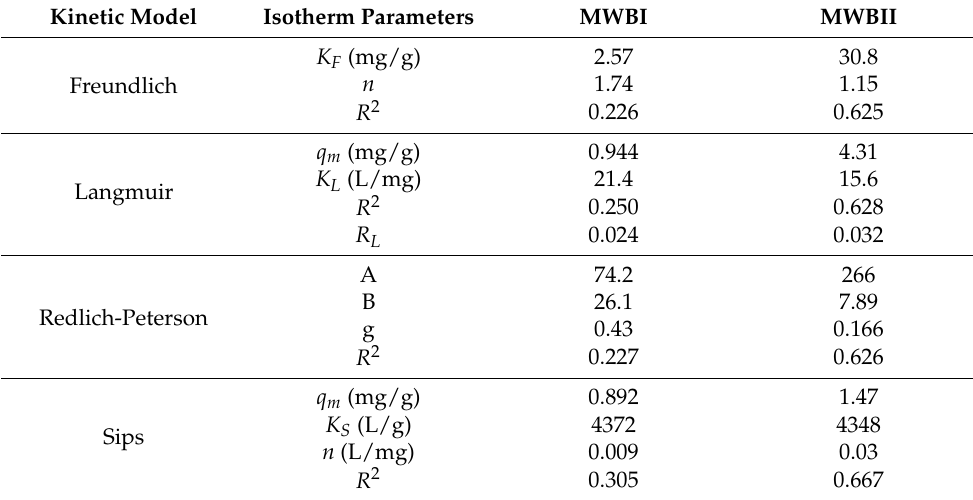
Table 4. Sorption parameters determined by Langmuir, Freundlich, Redlich-Peterson, and Sips isotherm models in non-linear form.